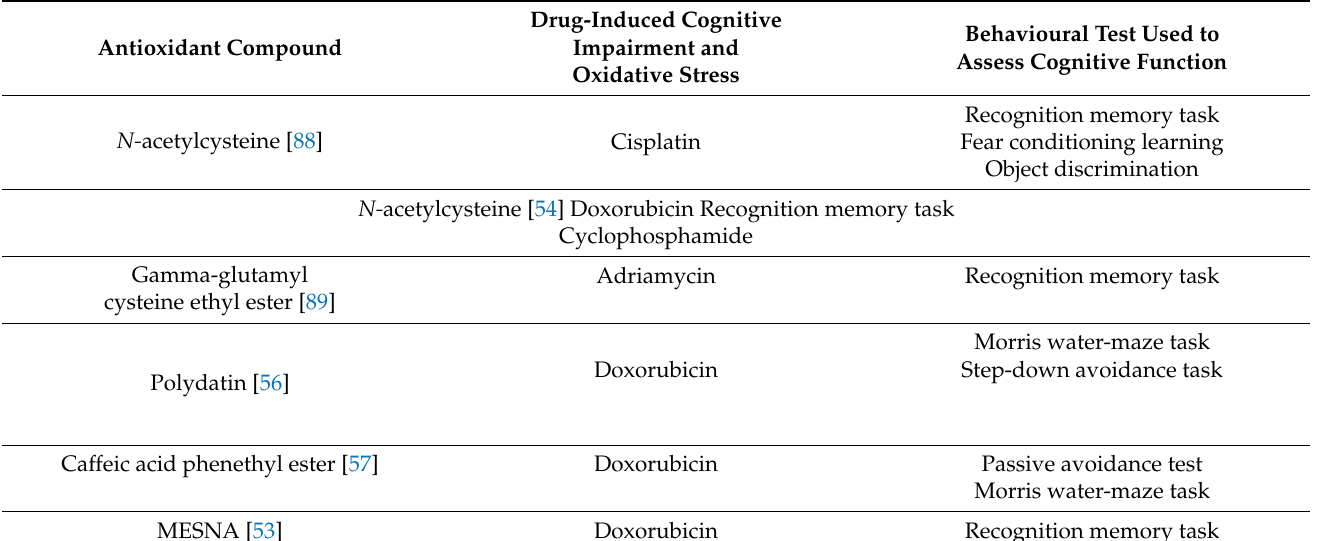
Table 1. Drugs proven to decrease both the oxidative stress and cognitive dysfunction induced by the administration of chemotherapeutic drugs in animal